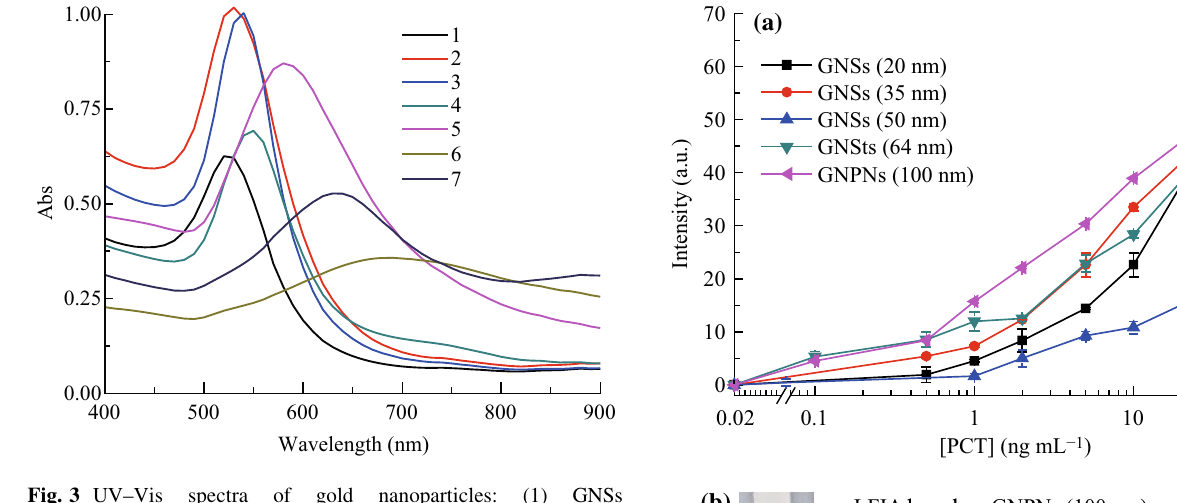
Fig. 3 UV–Vis spectra of gold nanoparticles: